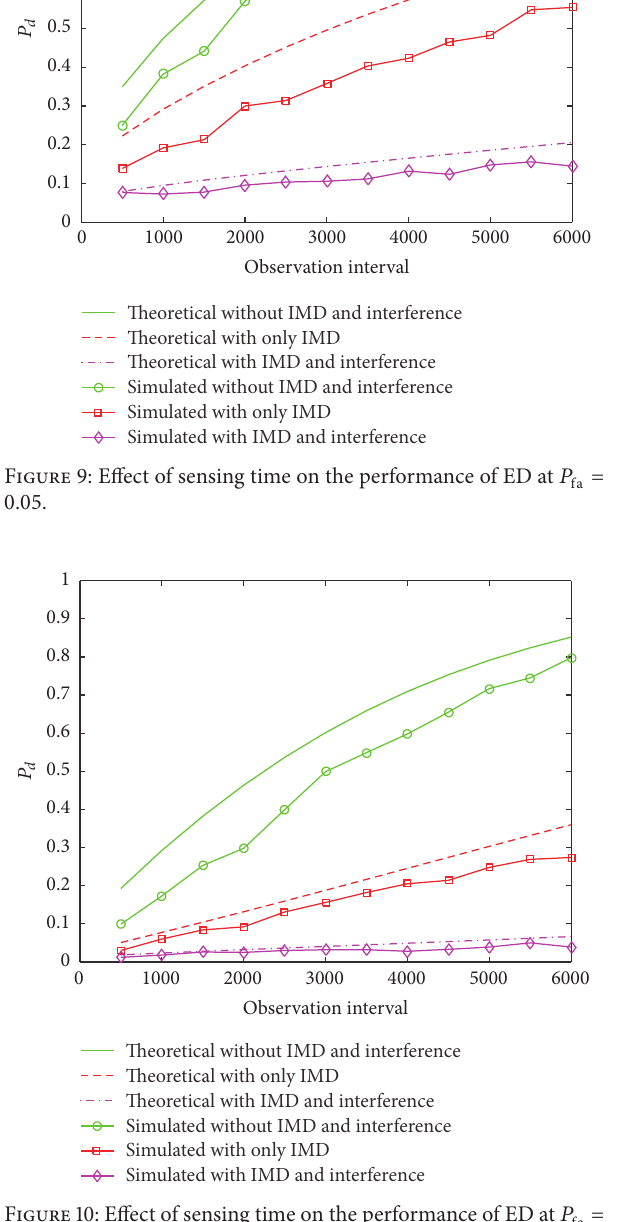
Figure 10: Effect of sensing time on the performance of ED at 𝑃 fa = 0.01 .